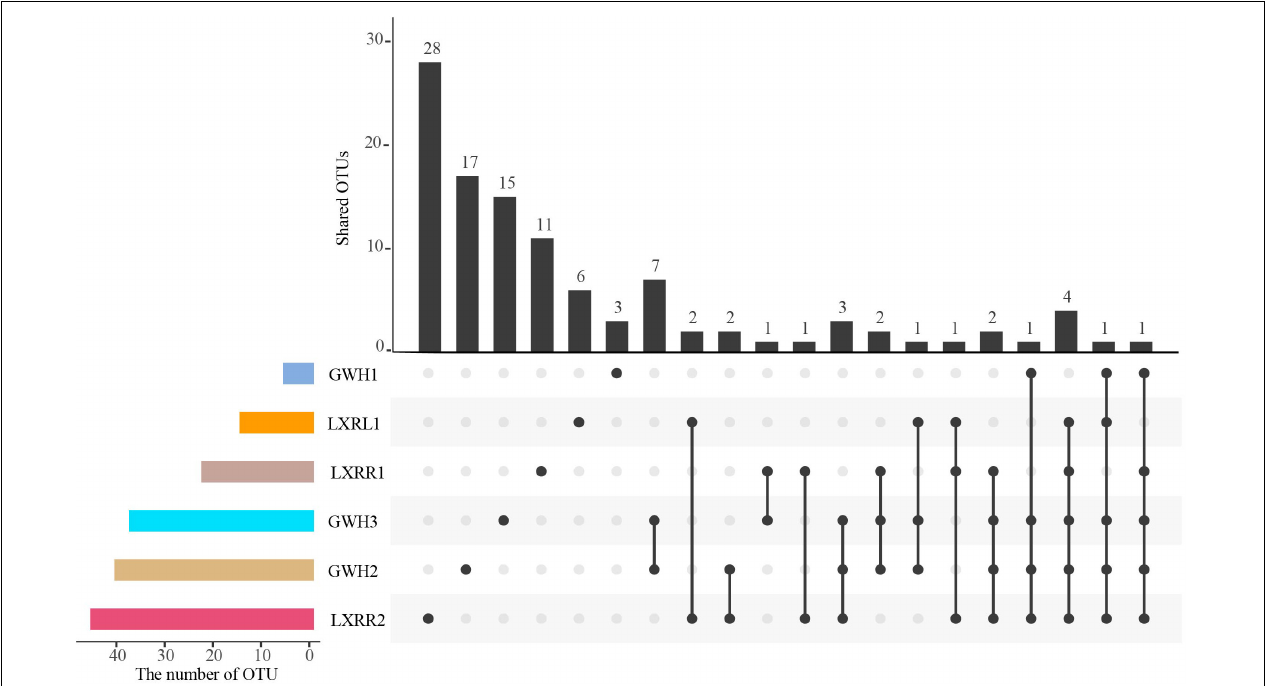
FIGURE 1 | An UpSetR plot showing the shared and unique OTUs at 97% similarity among the samples. UpSetR is an R package; it employs a matrix-based layout to show intersections of sets and their sizes, and it is implemented using ggplot2 and allows data analysts to easily generate UpSet plots for their own data. The strip at the bottom left shows the number of OTUs included in each sample. The dot and line at the bottom right represent the subsets of samples. The number of relevant OTUs in each subset is represented in the histogram, which is the upper part of the whole